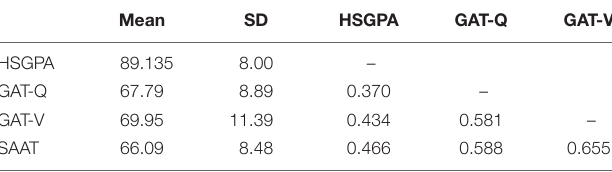
TABLE 3 | Correlations across the pre-university metrics.